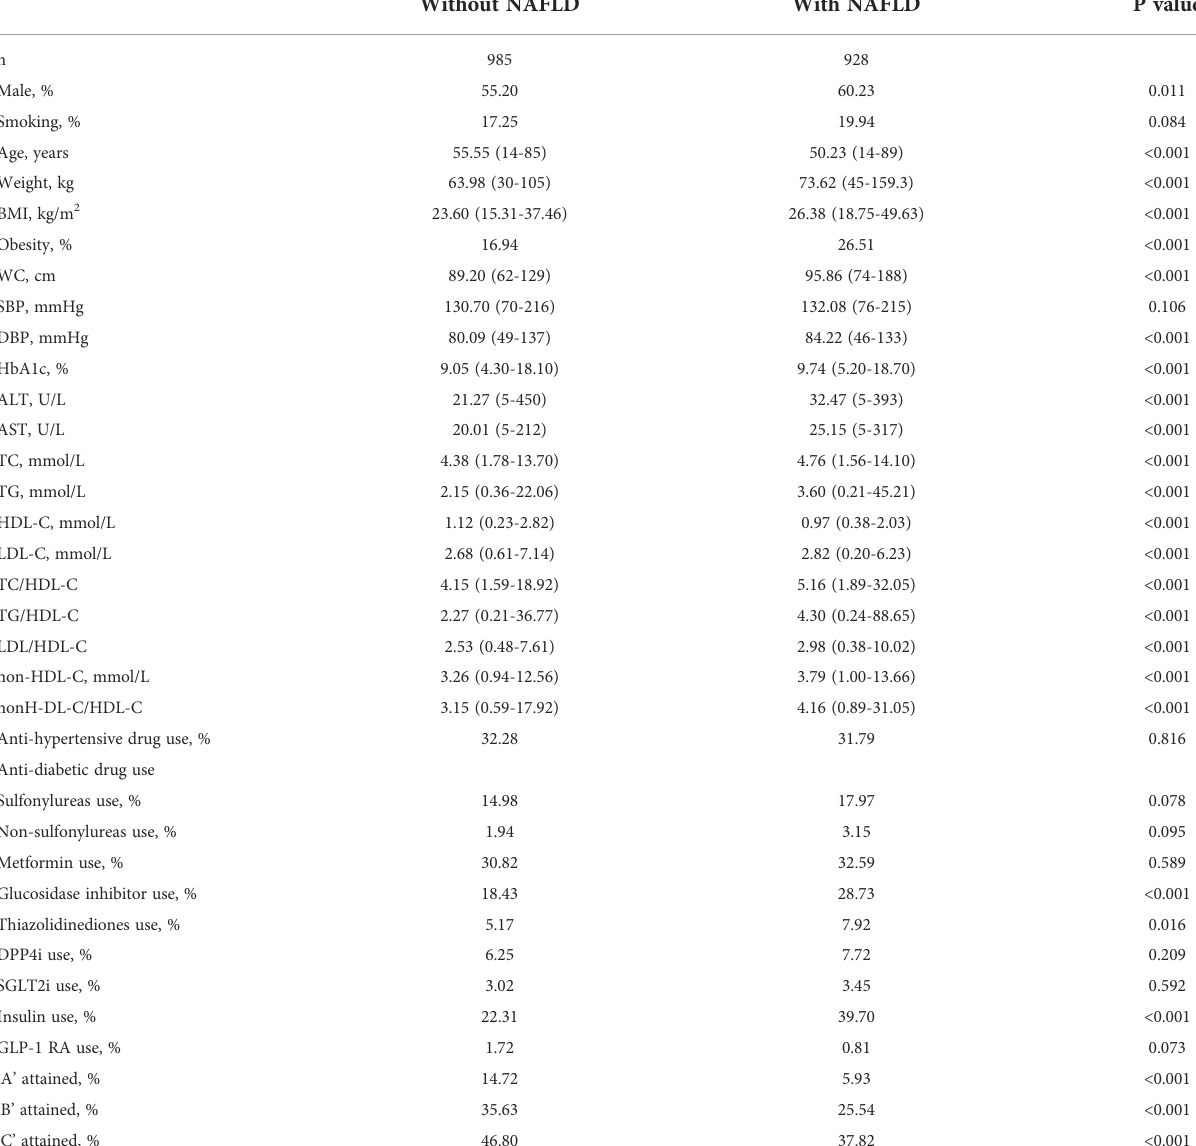
TABLE 1 Characteristics of participants according to non-alcoholic fatty liver disease status. Without NAFLD With NAFLD P